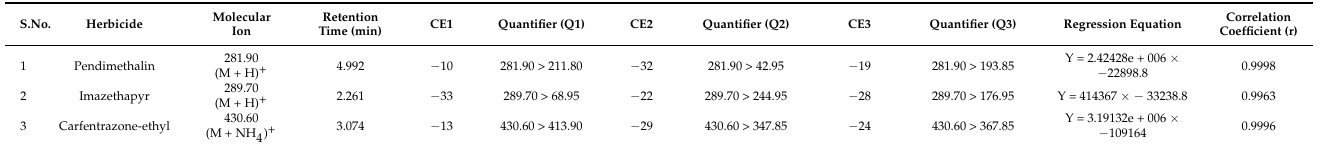
Table 2. LC-MS/MS parameters and regression equation of the